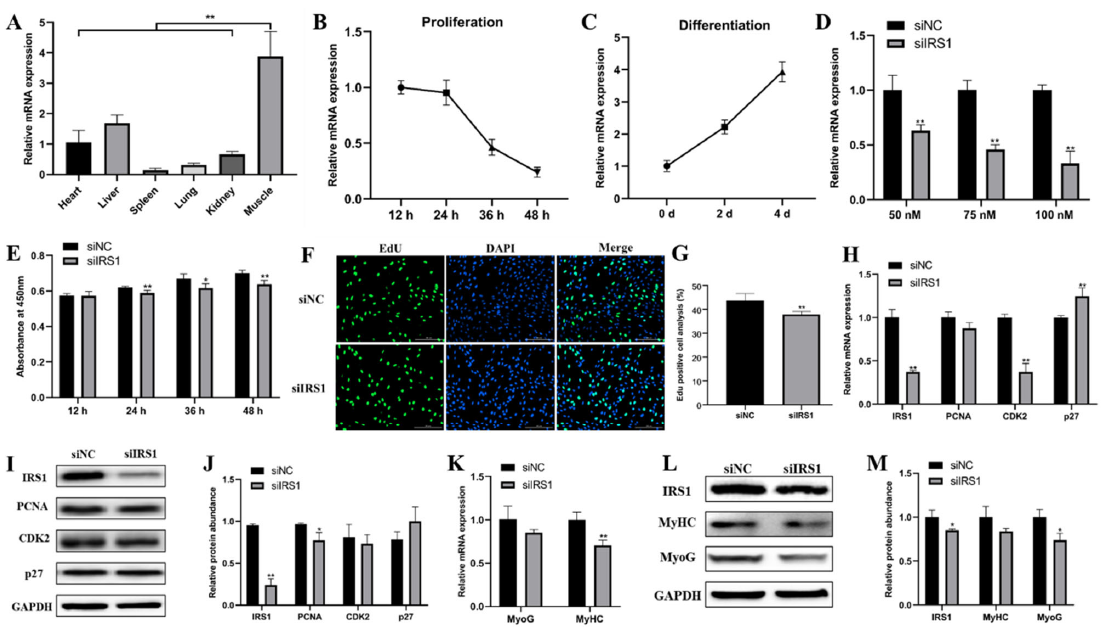
Figure 5. IRS1 knockdown suppresses goat myoblast proliferation and differentiation. ( A ) IRS1 expression pattern in dif ‐ ferent lamb tissues. ( B , C ) IRS1 expression profiles during goat myoblast proliferation and differentiation. ( D ) qRT ‐ PCR quantified IRS1 mRNA expression in goat myoblasts transfected with different siRNA concentrations. ( E ) Cell counting detected by CCK ‐ 8. ( F , G ) The cell proliferation index detected by the EdU assay. ( H – J ) qRT ‐ PCR and western blot analyses of the expression of proliferation marker genes ( PCNA , CDK2 , and p27 ) in goat myoblasts transfected with siIRS1 or siNC. ( K – M ) qRT ‐ PCR and western blot analyses of the expression of myogenic marker genes ( MyHC and MyoG ) in goat my ‐ oblasts transfected with siIRS1 or siNC. Data are shown by mean ± SEM of three independent experiments. * p < 0.05; ** p < 0.01.